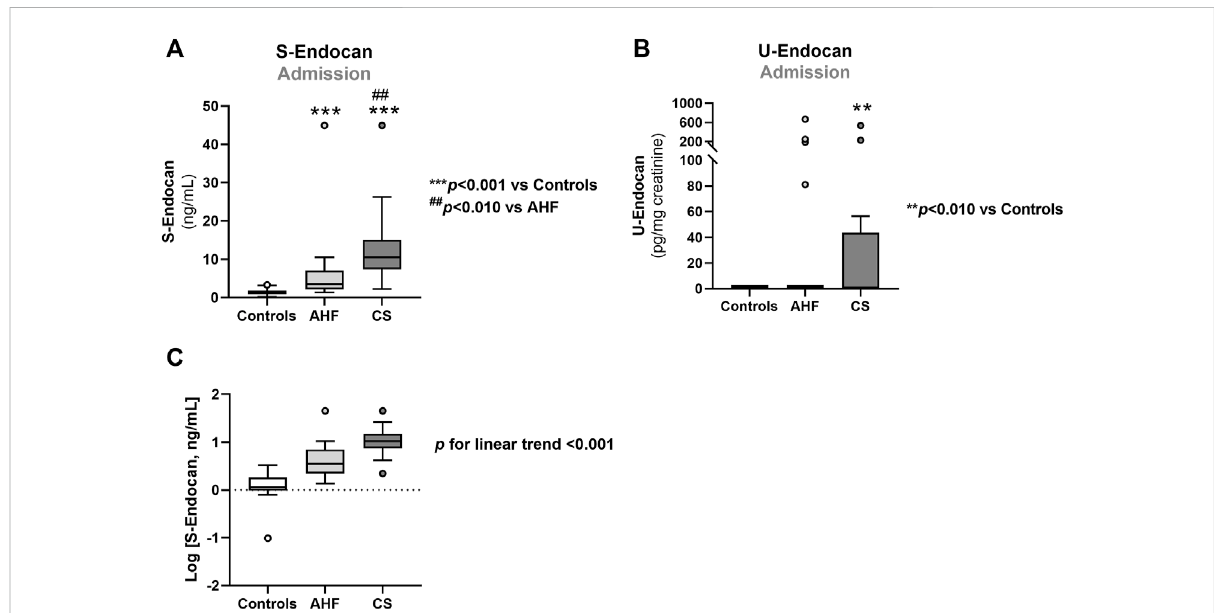
FIGURE 1 Serum endocan (A,C) and urinaryendocan (B) concentrationsat admission in controls, CSand AHF patients.Resultsare presented in Box-and- Whiskers plot. AHF, acute heart failure; CS, cardiogenic shock; S-Endocan, serum endocan; U-Endocan, urinary